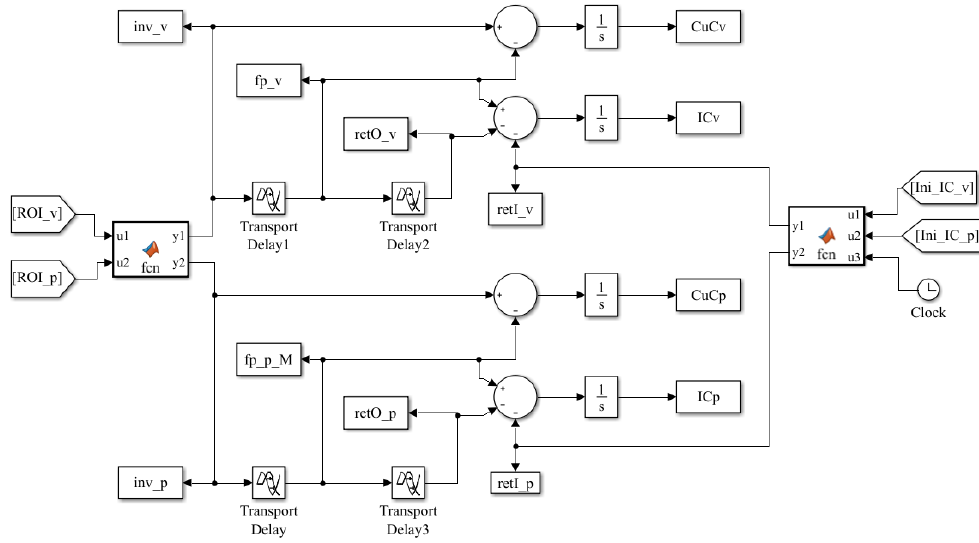
Figure A1. Supply side from (P) and (V) generation. Reprinted with the permission of Reference [13]. Copyright 2018 Elsevier.